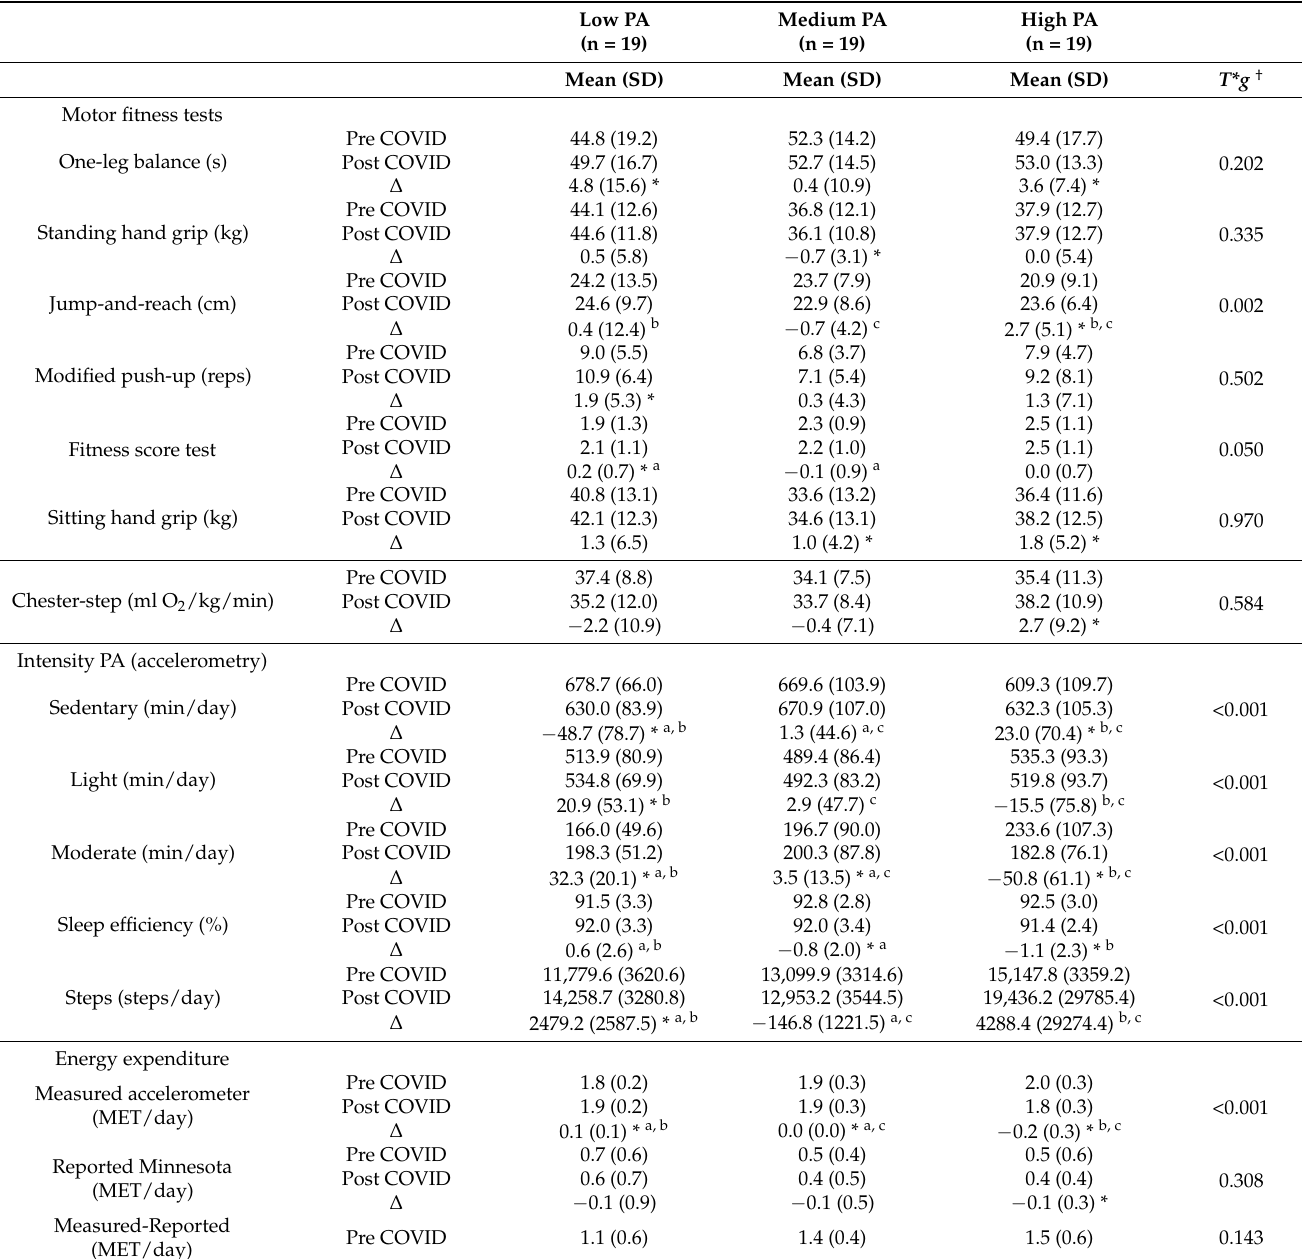
Table 2. Changes in physical activity parameters within and between PA difference groups pre- and